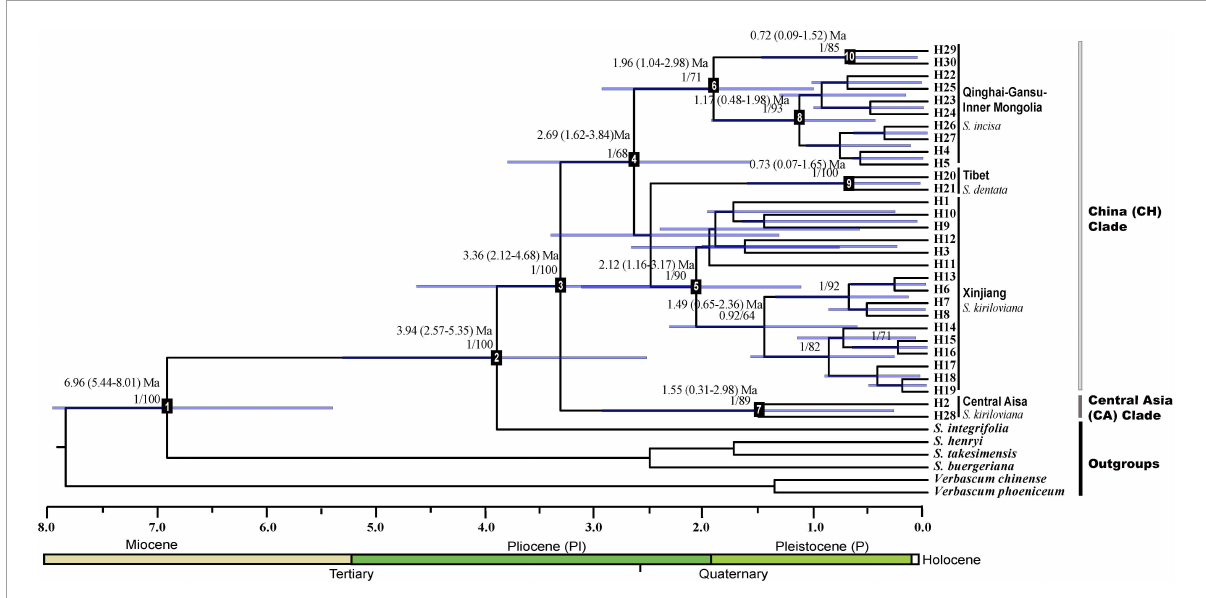
FIGURE2 BEAST-derived chronograms of the Scrophularia incisa complex based on cpDNA ( trn L– trn F, psb A– trn H, and trn Q– rps 16). Blue bars indicate the 95% highest posterior density (HPD) credibility intervals for node ages (in Myr ago, Ma). Posterior probabilities and bootstrap values ( > 50%) based on maximum-likelihood (ML) analysis are sequentially labeled above nodes. Mean divergence dates and 95% HPDs for major nodes (1–10) are summarized in Table 2 . Haplotypes are indicated by letter codes